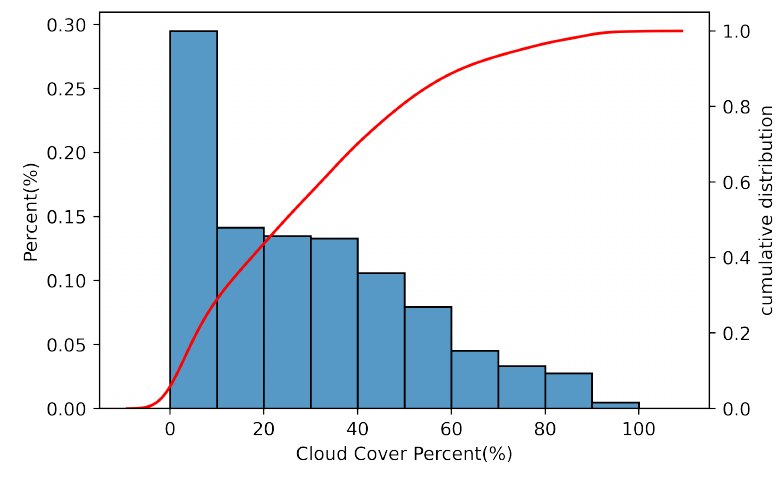
Figure 11. Distribution of cloud fraction.